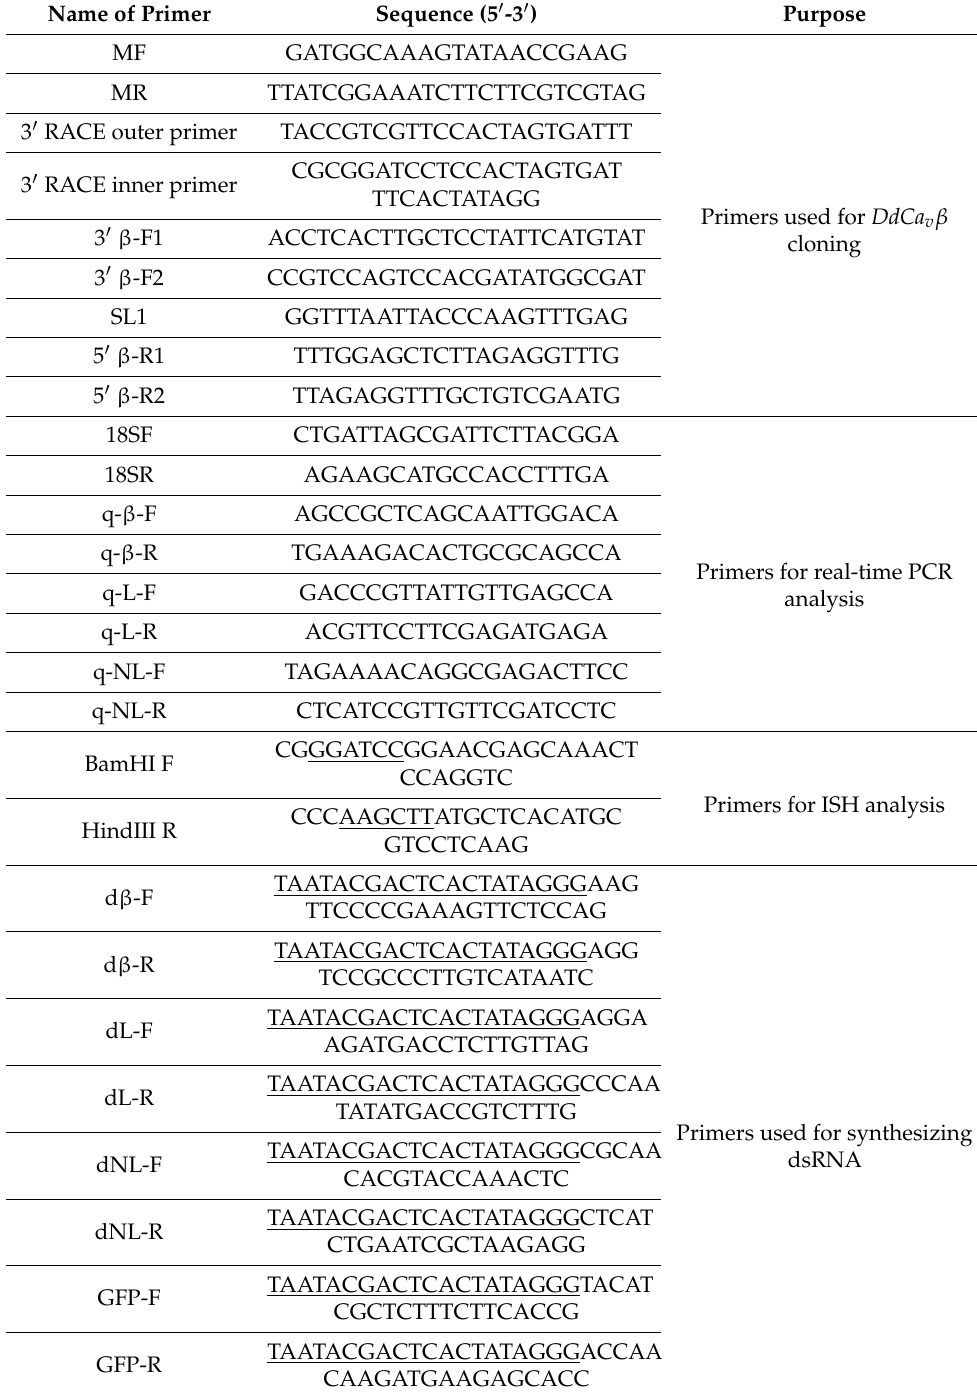
Table 2. Polymerase chain reaction (PCR)